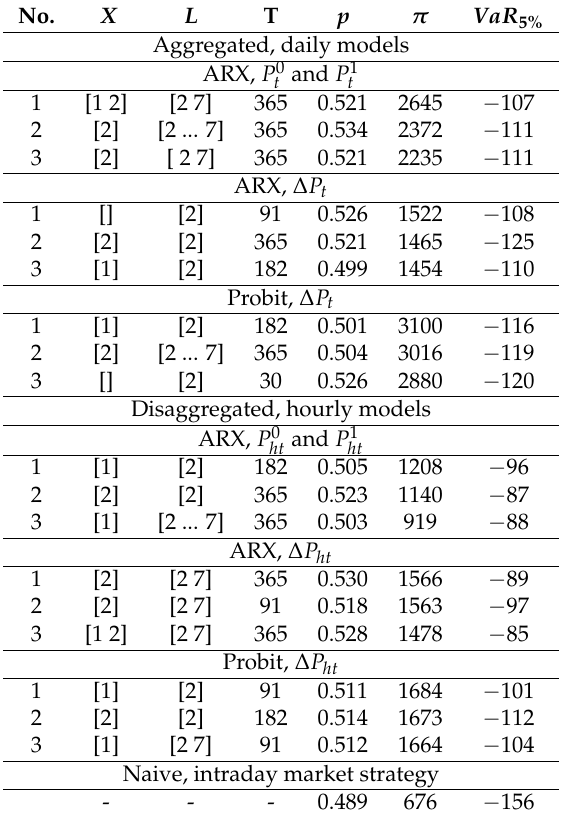
Table 6. The comparison of profits and risks for German data. Note that the results for only the top three, best-performing model specifications, in terms of total yearly profit π , relative to the day-ahead strategy, are reported in each